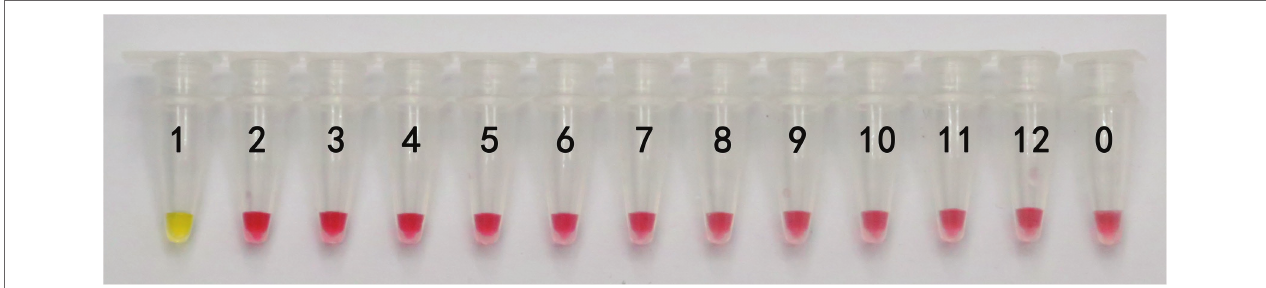
FIGURE 3 | The specificity results of the LAMP primer set I of Gyromitra infula. The specificity of primer set I was tested with Gyromitra infula and 11 other related species. 1. Gyromitra infula ; 2. Helvella crispa ; 3. Gyromitra gigas ; 4. Suillus placidus ; 5. Inocybe rimosa ; 6. Amanita virgineoides ; 7. Suillus bovinus ; 8. Gyromitra esculenta ; 9. Verpa bohemica ; 10. Peziza badia ; 11. Morchella esculenta ; 12. Helvella macropus ; 0. ddH 2